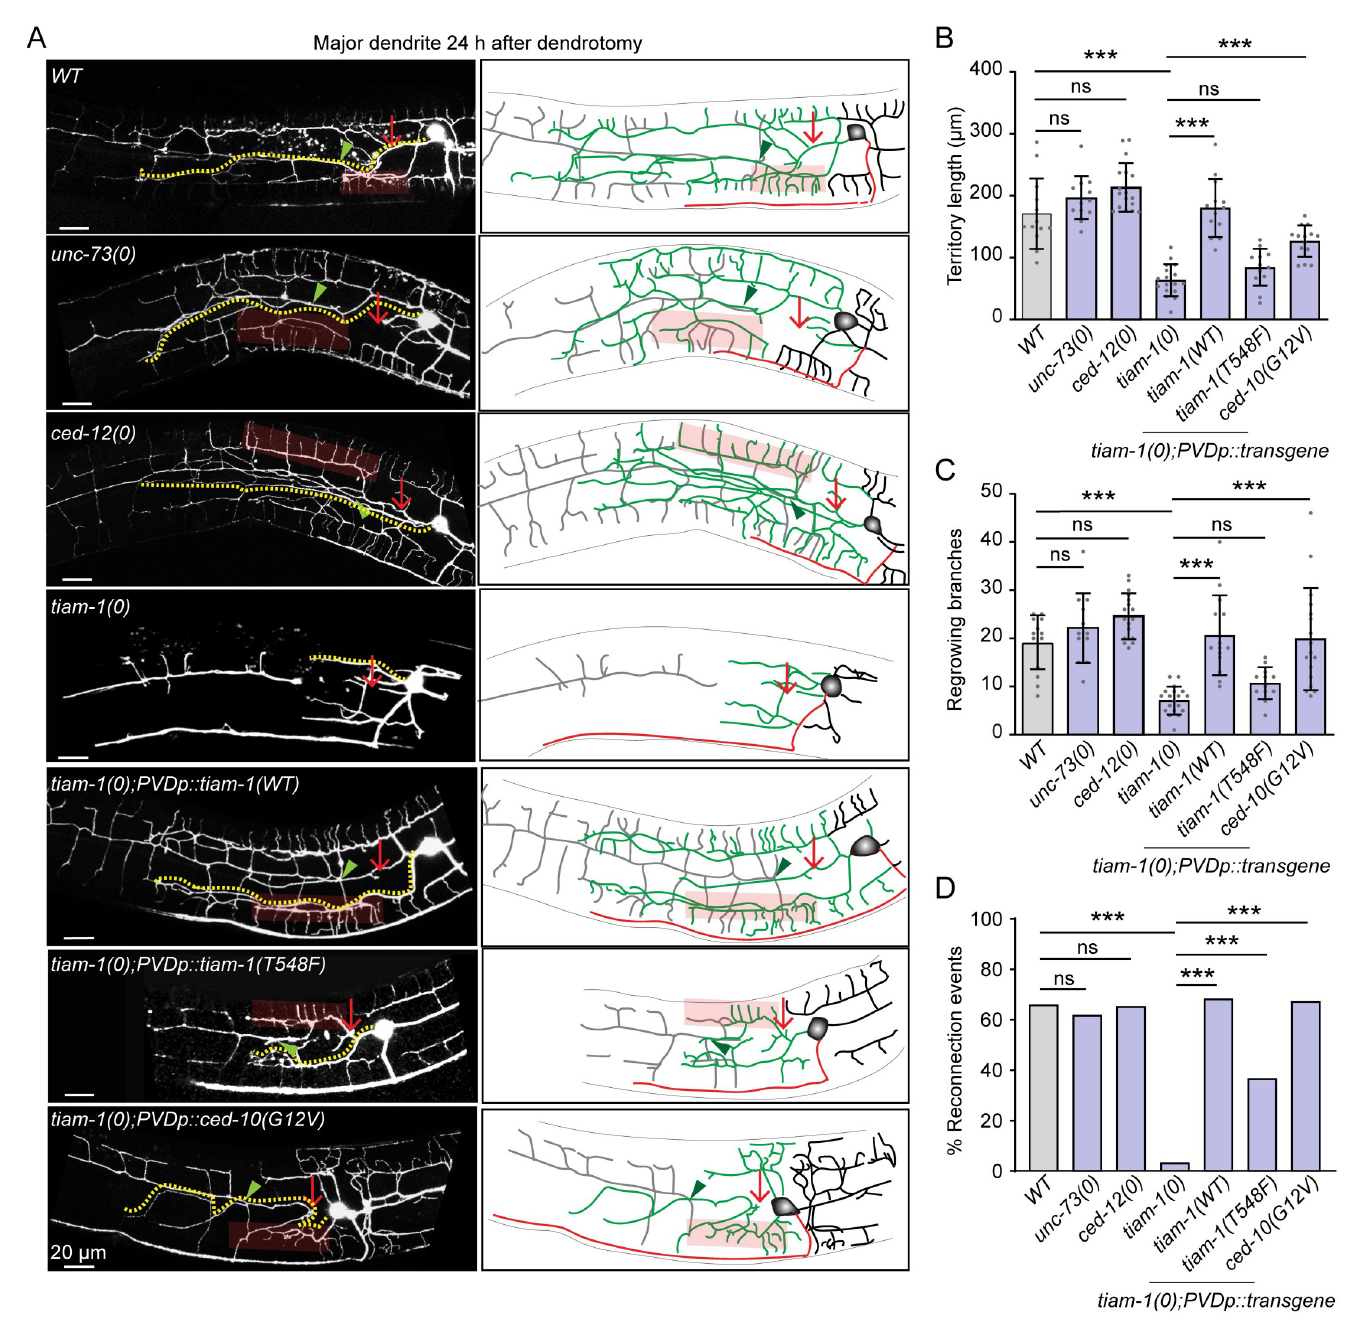
Fig 6. TIAM-1 acts upstream to CED-10 for dendrite regeneration. (A) Confocal images of dendrotomized PVD neuron in the wild type, unc-73(0) , ced-12(0) , tiam-1 (0) , pser2prom3 :: tiam-1WT (5ng); tiam-1(0) , pser2prom3 :: tiam-1(T548F)5ng;tiam-1(0) and pser2prom3 :: ced-10(G12V) 5ng;tiam-1(0) at 24h post-injury. The regrowing dendrites, axon, and the distal part of dendrite are represented in green, red, and grey color, respectively. The green arrowheads represent reconnection events and the faded red rectangular boxes indicate menorah-menorah fusion event. (B-C) The quantification of territory length (B), and the the number of regrowing branches (C) in the above mentioned genotypes. N = 3–5 independent replicates, n (number of regrowth events) = 10–29. (D) The bar chart represents the percentage of reconnection events for the above mentioned genotypes, N = 3–5 independent replicates, n (number of regrowth events) = 10–29. Statistics, For B-C, one-way ANOVA with Tukey’s multiple comparison test, p < 0.05 � , 0.01 �� , 0.001 ��� . For D, Fisher’s exact test, p < 0.05 � , 0.01 �� , 0.001 ��� . Error bars represent SD. ns, not significant.